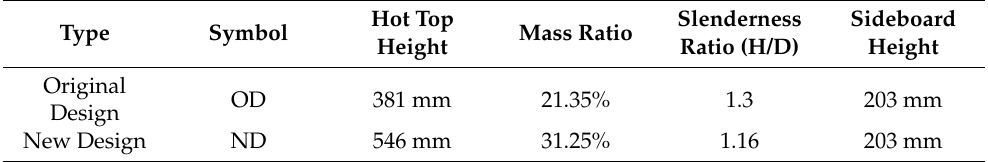
Table 3. Characteristics of the hot top in the original and in the new